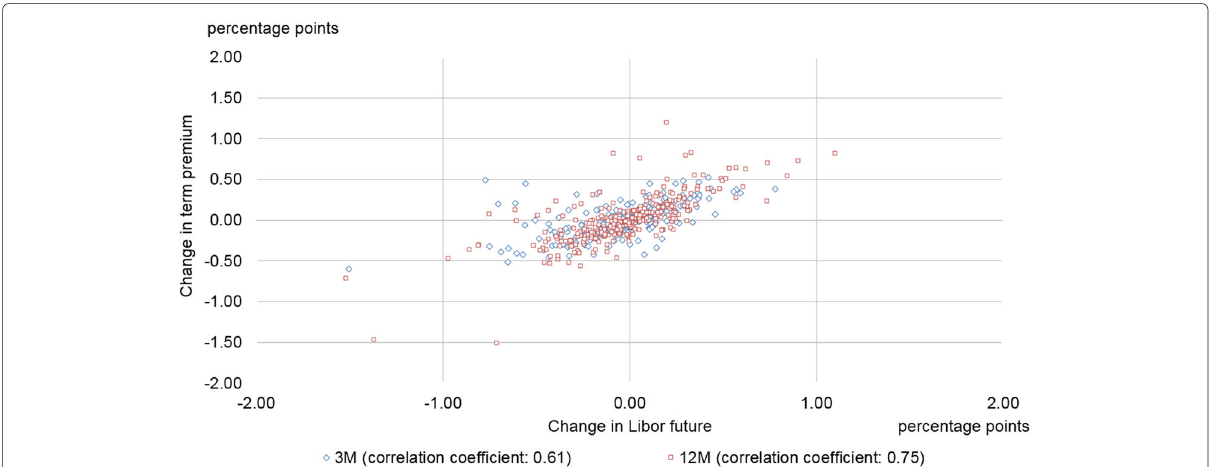
Fig. 4 Correlation of LIBOR futures and term premium. The figure shows a scatterplot of monthly changes in LIBOR futures and monthly changes in the term premium for the 3-month and the 12-month